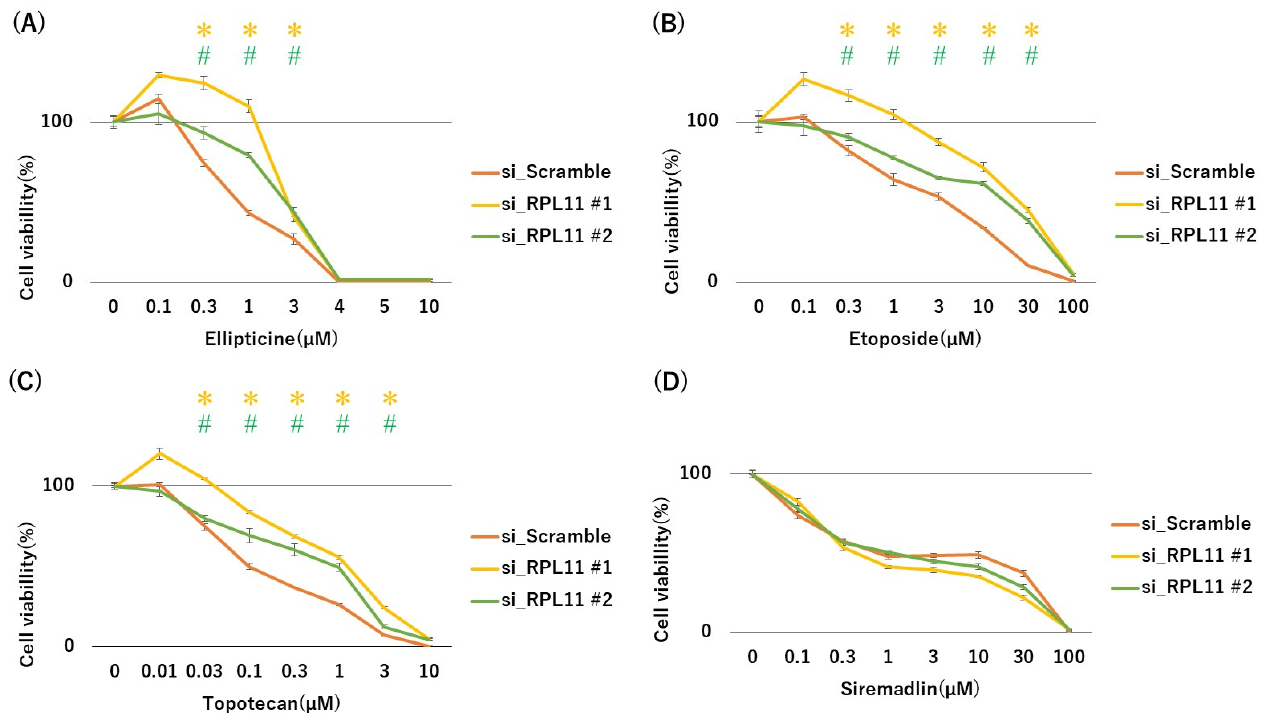
Figure 1. RPL11-mediated nucleolar stress response regulates sensitivity to topoisomerase inhibitors in p53 wild-type malignant rhabdoid tumor JMU-RTK-2 cells. Cells were transfected with scramble, RPL11#1, and RPL11#2 siRNAs and treated with the indicated concentrations of drugs (( A ) Ellipticine, ( B ) Etoposide, ( C ) Topotecan, ( D ) Siremadlin). After 3 days of culture, the number of surviving cells was measured using the MTT assay. * p < 0.05 vs.RPL11#1 siRNA group; # p < 0.05 vs. RPL11#2 siRNA group. Results represent independent five experiments.